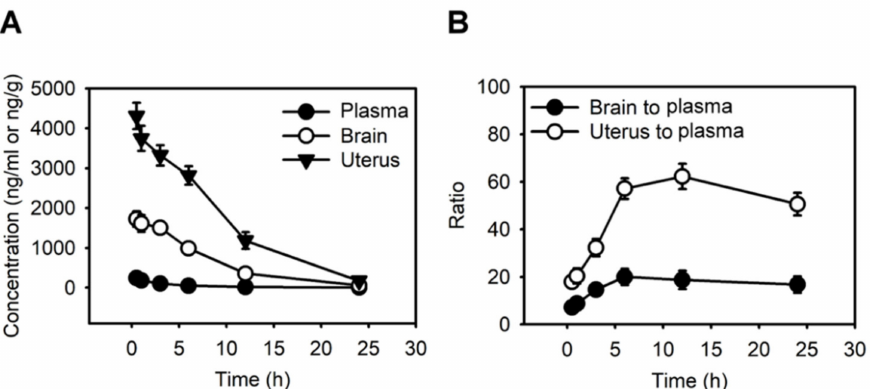
Figure 2. Haloperidol highly accumulates in the uterus. ( A ) The concentration-time profiles of haloperidol in plasma, brain, and uterus of adult C57BL/6J mice following single intravenous administrations of 1 mg/kg haloperidol. ( B ) Brain-to-plasma and uterus-to-plasma concentration ratios for haloperidol. Data are presented as means ± SD (n =